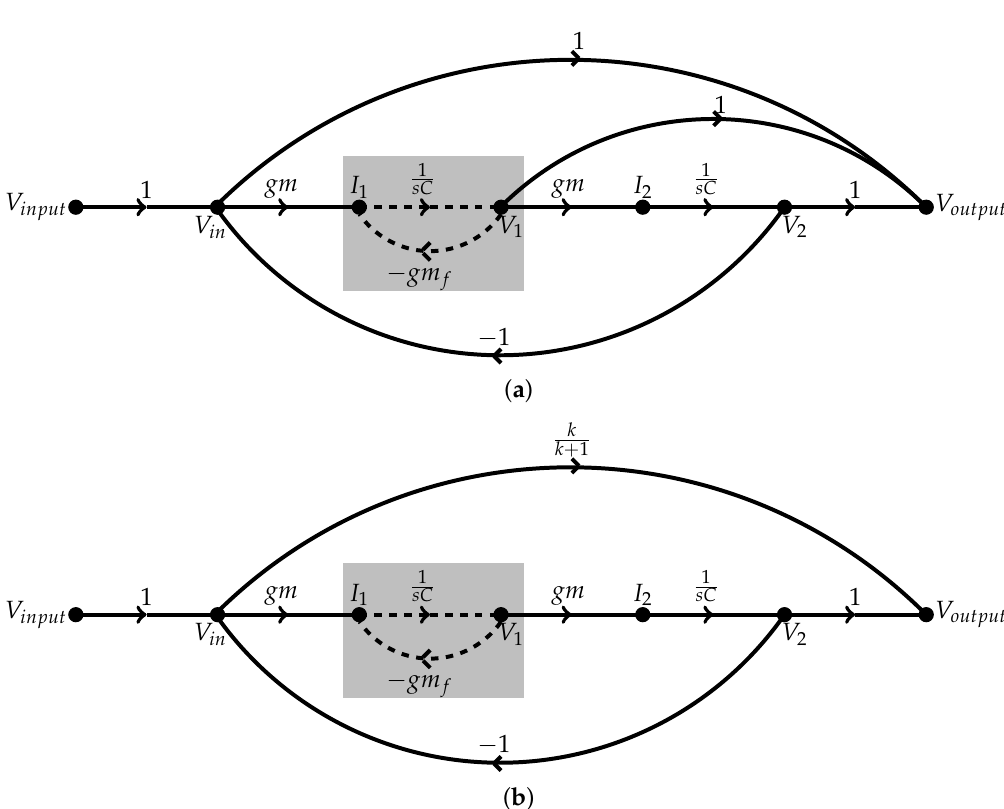
Figure 4. SFGs in controllable canonical form of: ( a ) the proposed general gm-C biquad filter structure; ( b ) the proposed notch gm-C biquad